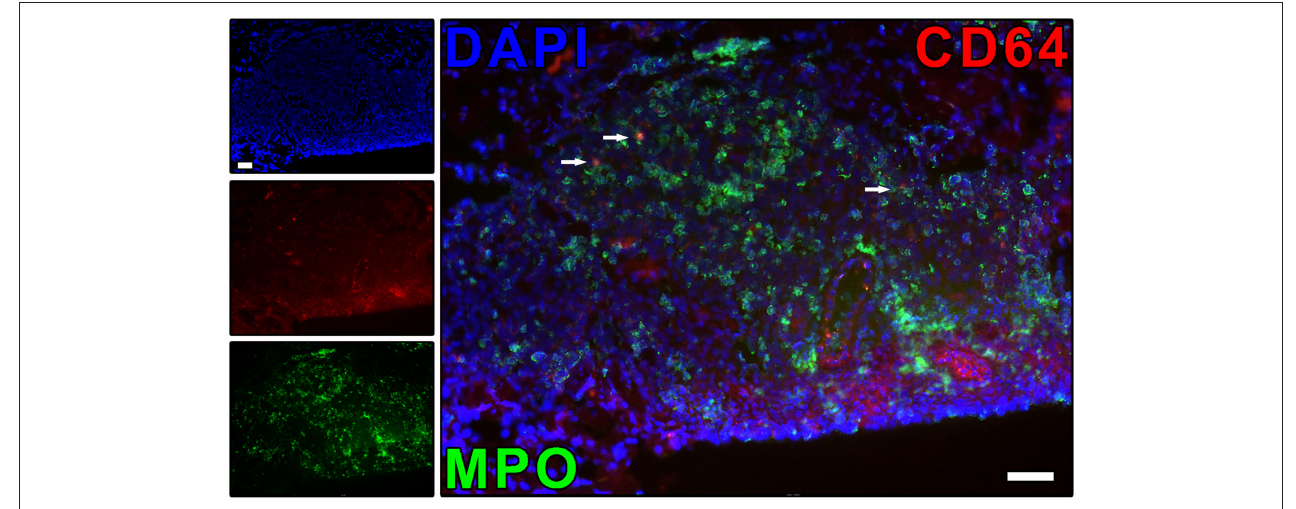
FIGURE 3 | ENL skin lesions present neutrophils expressing CD64. The protein expression of CD64 on neutrophil (MPO + cells) was evaluated by immunofluorescence. Skin lesion was stained for CD64 (red), myeloperoxidase (MPO; green), and nuclei (DAPI; blue). Images are representative of three independent samples of ENL patients. Co-localized areas of MPO + CD64 + cells were identified with arrows. The regulation of neutrophil CD64 expression has the potential to be useful in the ENL treatment, as well as to prevent ENL reactional episodes. Scale bars: 10 µ m. Images from Leprosy Laboratory